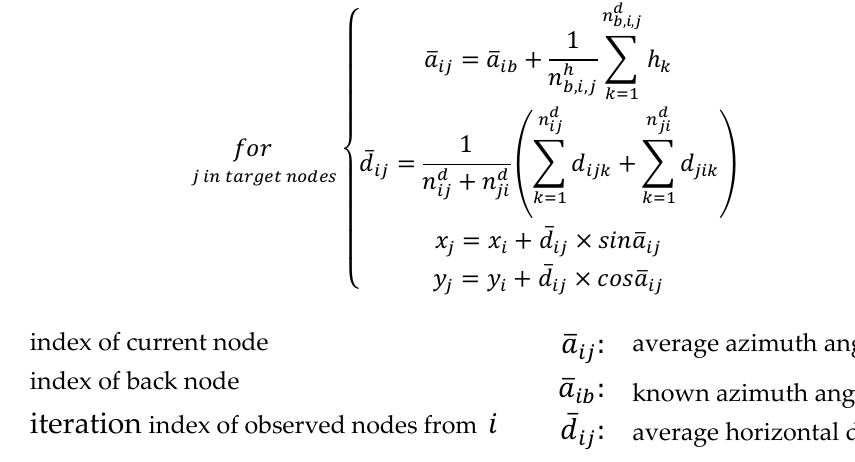
Figure 12. Calculation formulas.